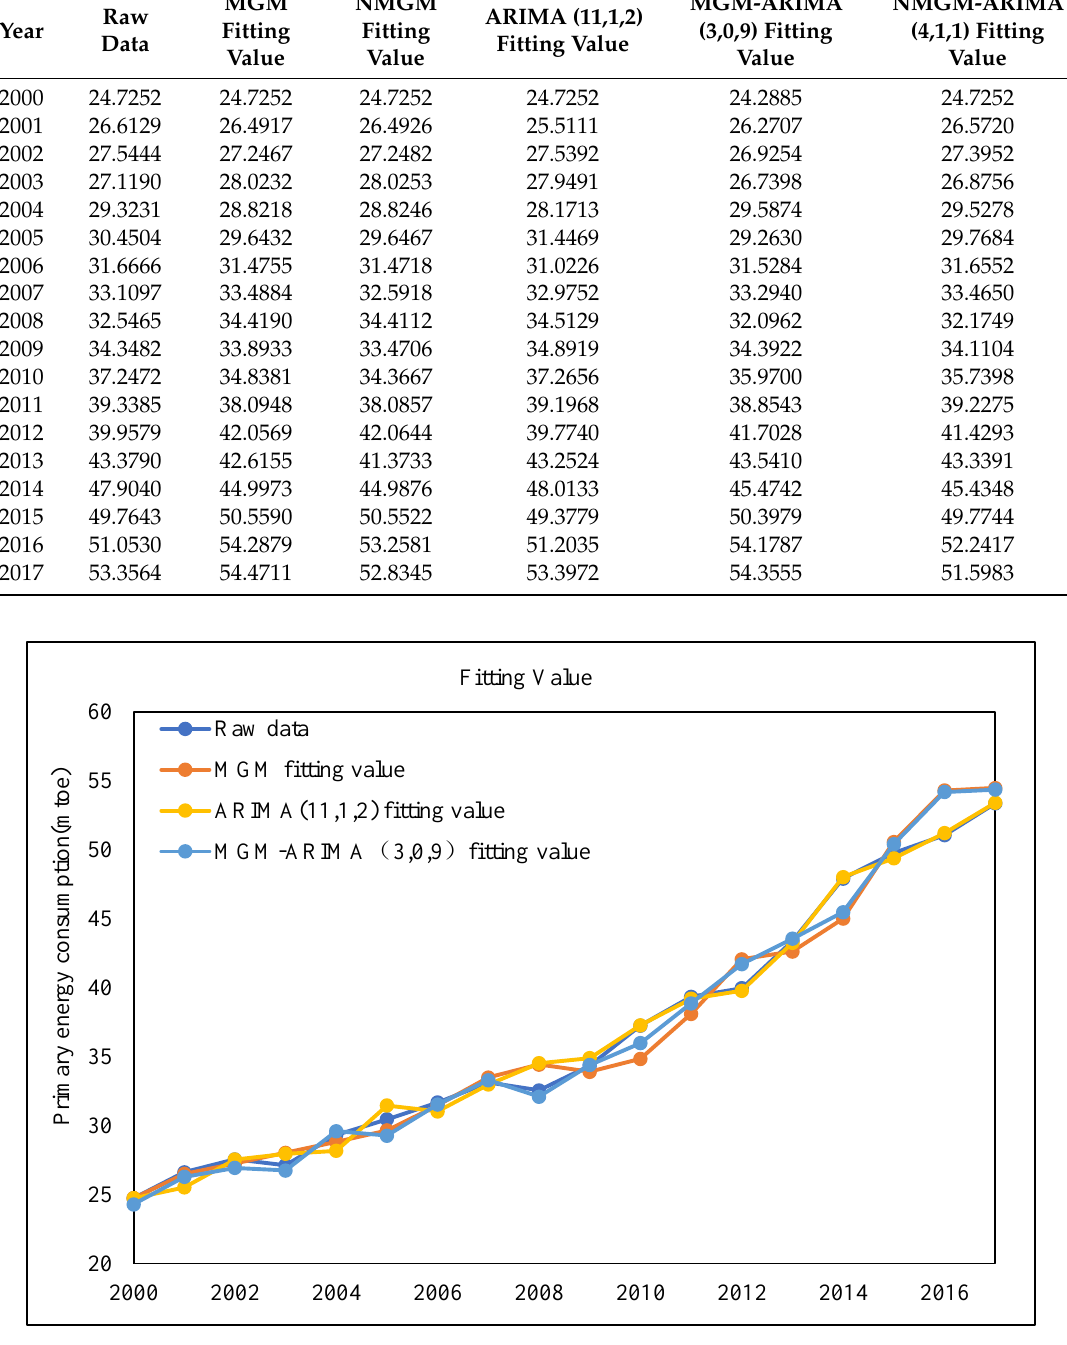
Figure 9. Comparison of MGM and MGM-ARIMA.